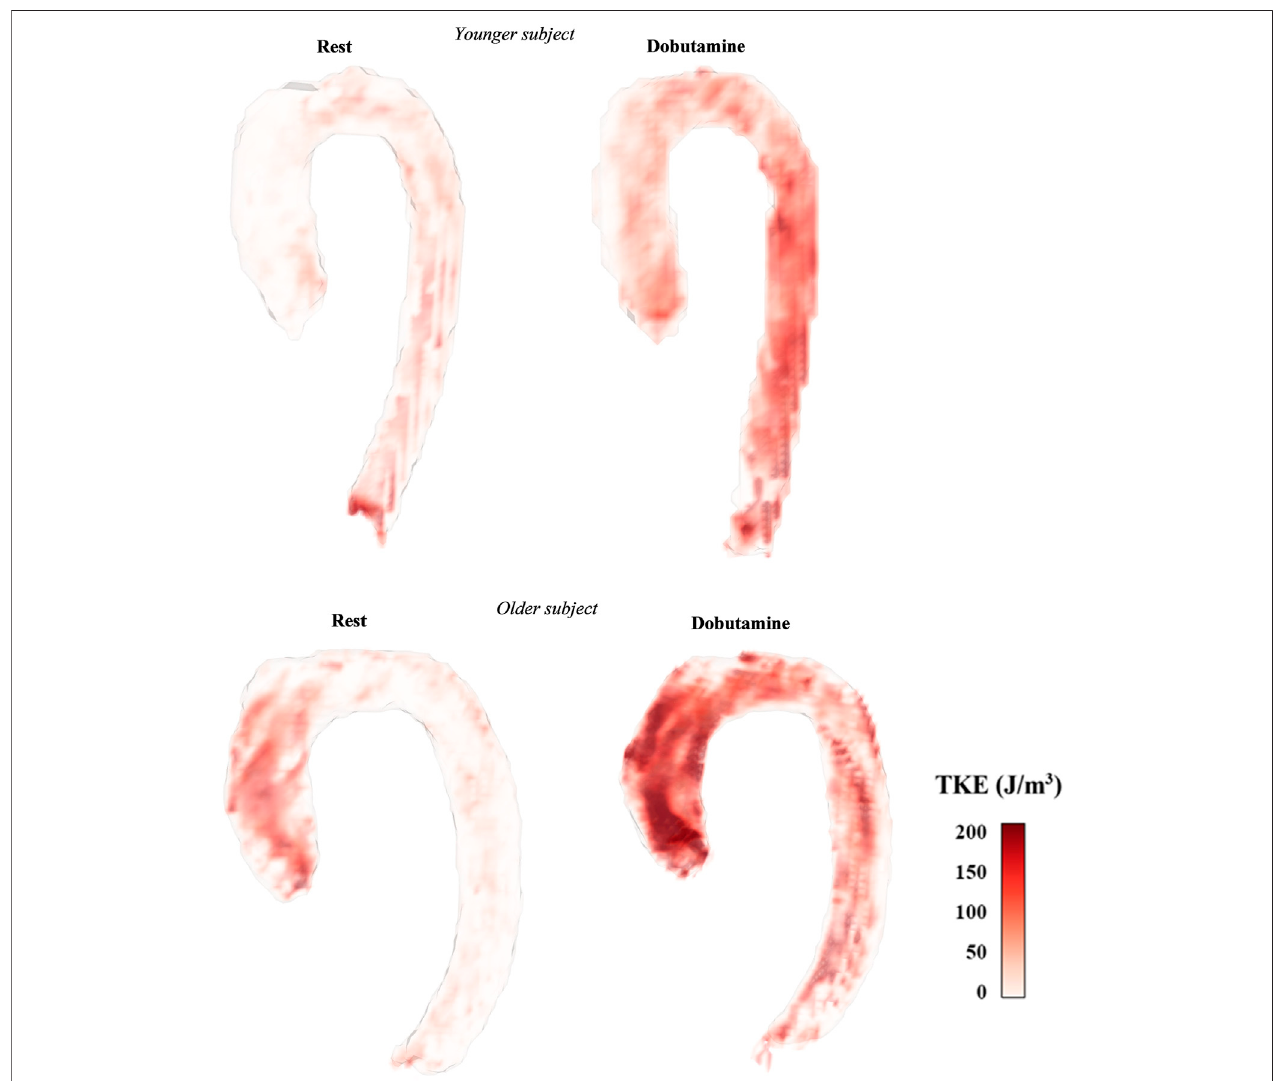
FIGURE 3 | Map of TKE at the timeframe of TAo peak TKE total in two of the healthy subjects with different TKE patterns and different age (younger = 20 years old, older = 56 years old).